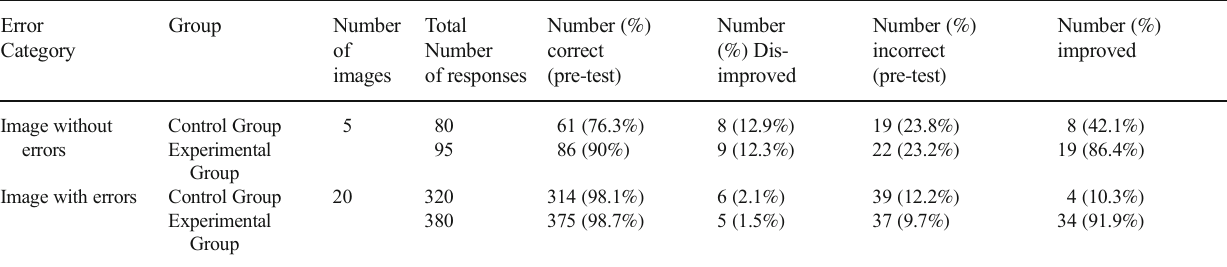
Variations in radiographer responses to the recognition of MR image-quality errors Error Category